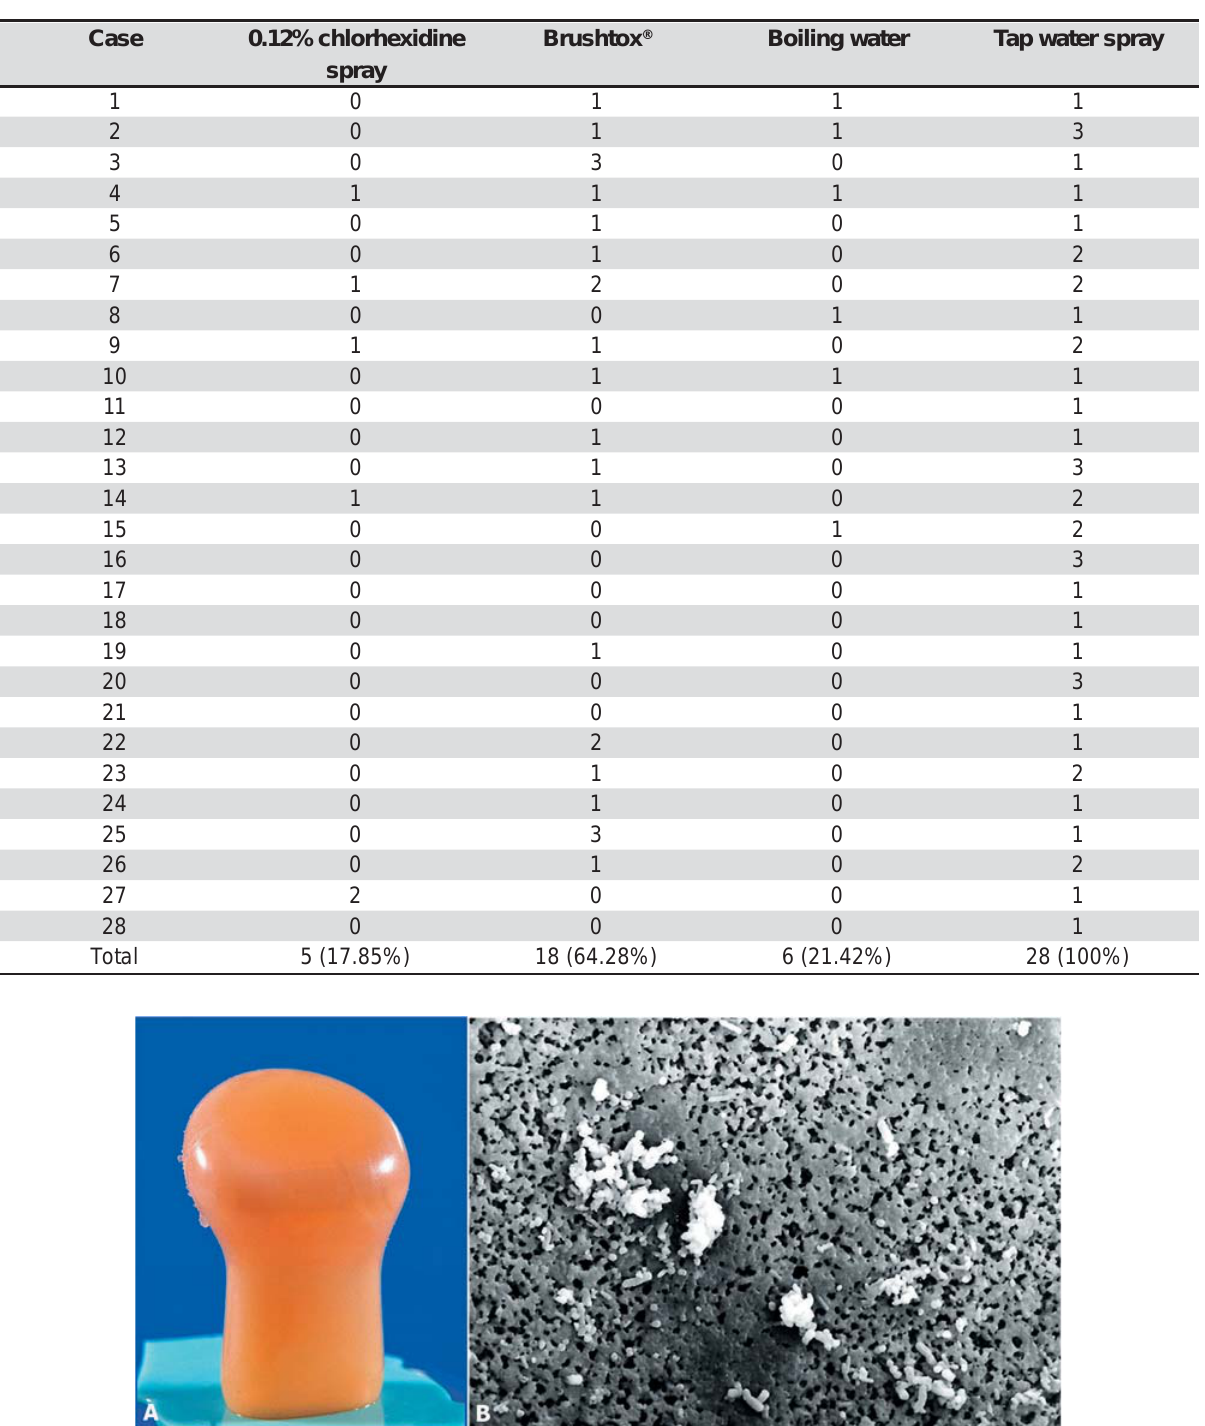
Figure 1- (cid:3)(cid:19)(cid:17)(cid:20)(cid:21)(cid:8)(cid:3)(cid:70)(cid:75)(cid:79)(cid:82)(cid:85)(cid:75)(cid:72)(cid:91)(cid:76)(cid:71)(cid:76)(cid:81)(cid:72)(cid:3)(cid:86)(cid:83)(cid:85)(cid:68)(cid:92)(cid:3)(cid:177)(cid:3)(cid:38)(cid:82)(cid:79)(cid:82)(cid:81)(cid:76)(cid:86)(cid:18)(cid:69)(cid:76)(cid:82)(cid:191)(cid:79)(cid:80)(cid:86)(cid:3)(cid:82)(cid:73)(cid:3) Mutans streptococci after microbial culture (A) and scanning electron microscopy micrograph